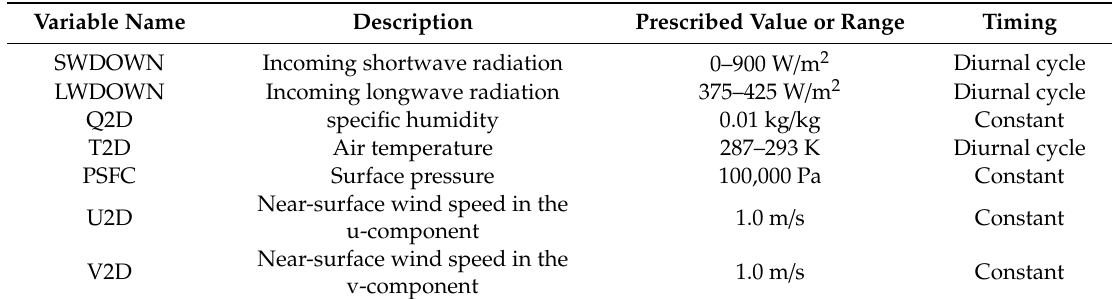
Table 8. The values of ideal